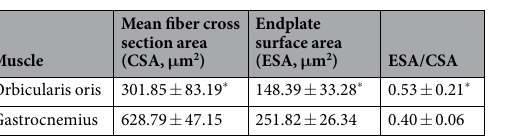
Table 2. Morphological data for normal facial nerve-innervated orbicularis oris and tibial nerve-innervated gastrocnemius. The size of the ESA was measured by analyzing the circumference of the total endplate region from transverse sections. The size of the mean fiber CSA was measured from longitudinal sections in the same way. Values are means ± standard deviation. Significant differences detected by the paired t- test. * P < 0.05 vs.